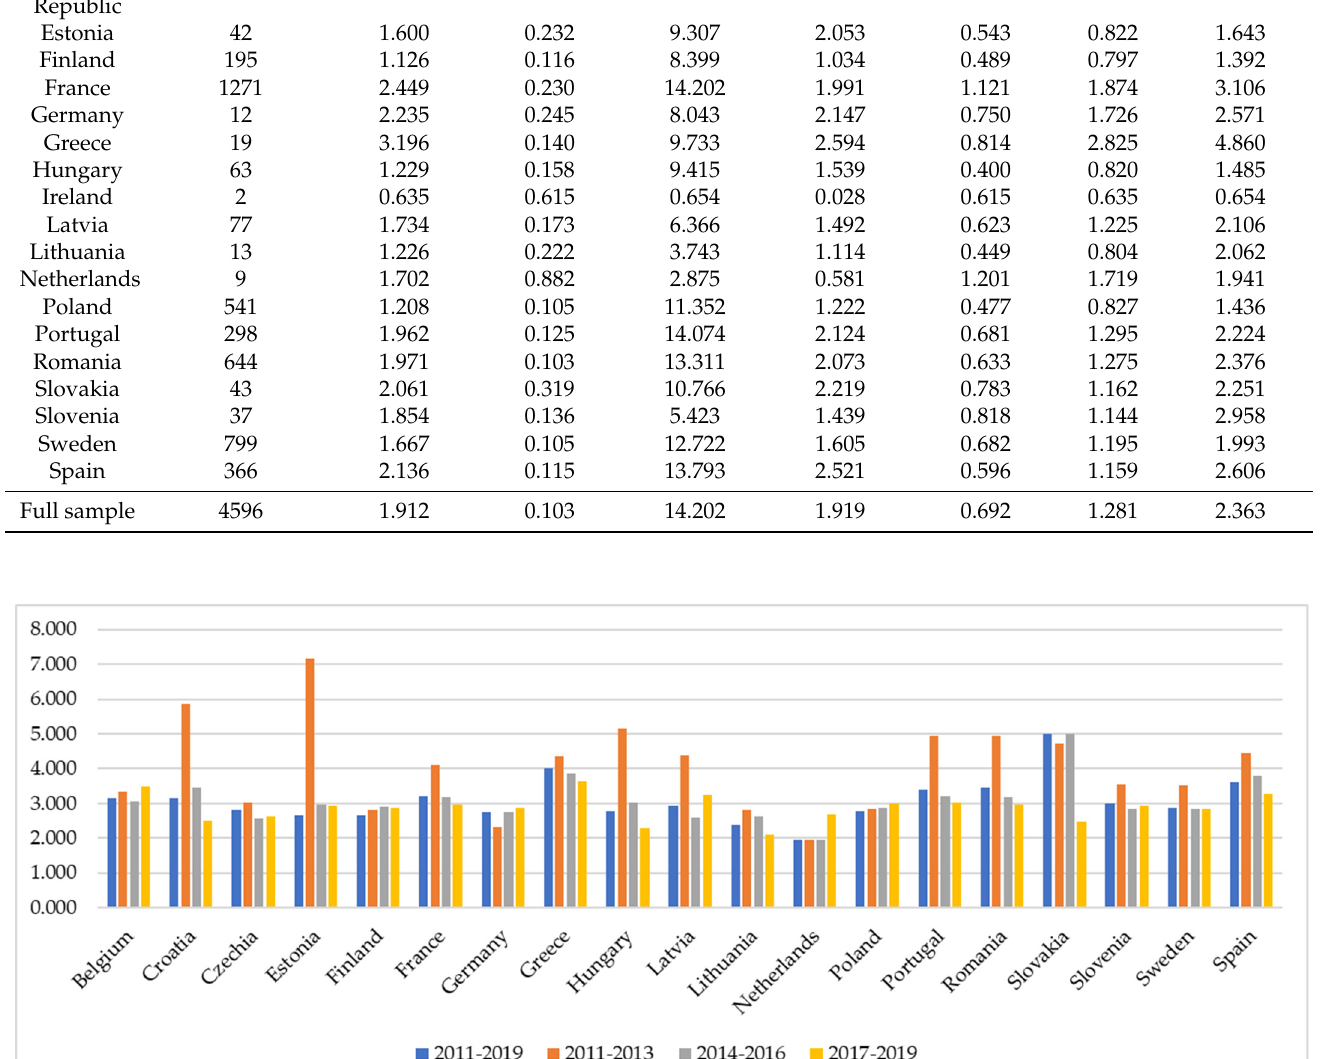
Figure A2. Solvency risk by country, full period, and three sub ‐ periods—medium solvency risk category. Note: the graph shows the median values of the TD/SF ratio. Figure A3. Solvency risk by country, full period, and three sub ‐ periods—low solvency risk category. Note: the graph shows the median values of the TD/SF ratio.